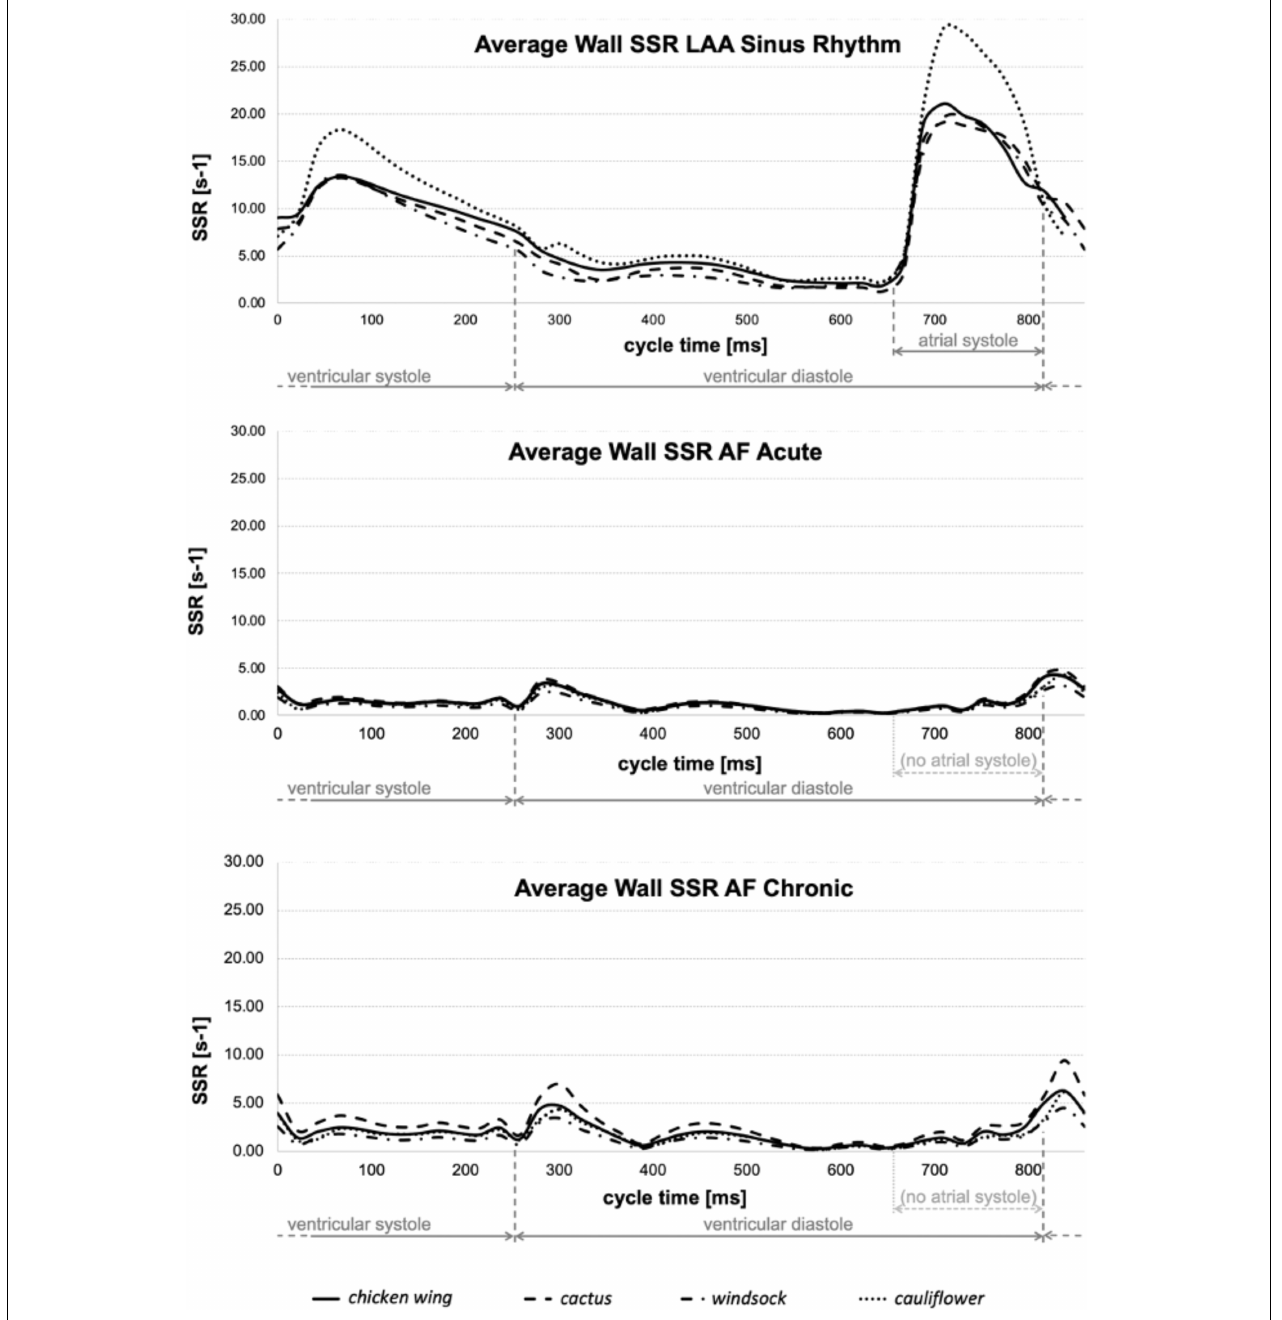
FIGURE 5 | Average wall SSR estimated for all models in sinus rhythm (top) , acute AF (middle) , and chronic AF (bottom) conditions.